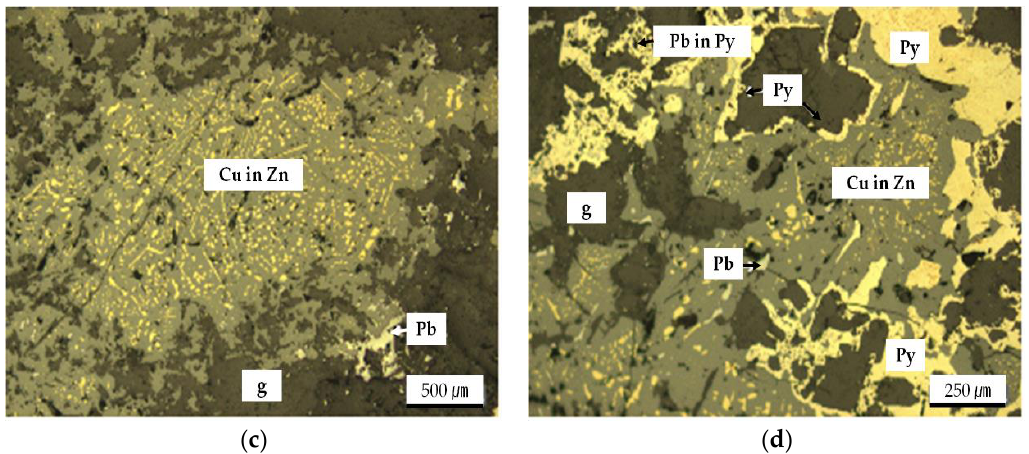
Figure 3. Images of ore texture in various thin sections of the feed sample: ( a ) 400×; ( b ) 200×; ( c ) 50×; ( d ) 100×. (Abbreviations: Cu, chalcopyrite; Zn, sphalerite; Pho, pyrrhotite; Pb, galena; Bi, bismuth; g, pyroxene; Py, pyrite).